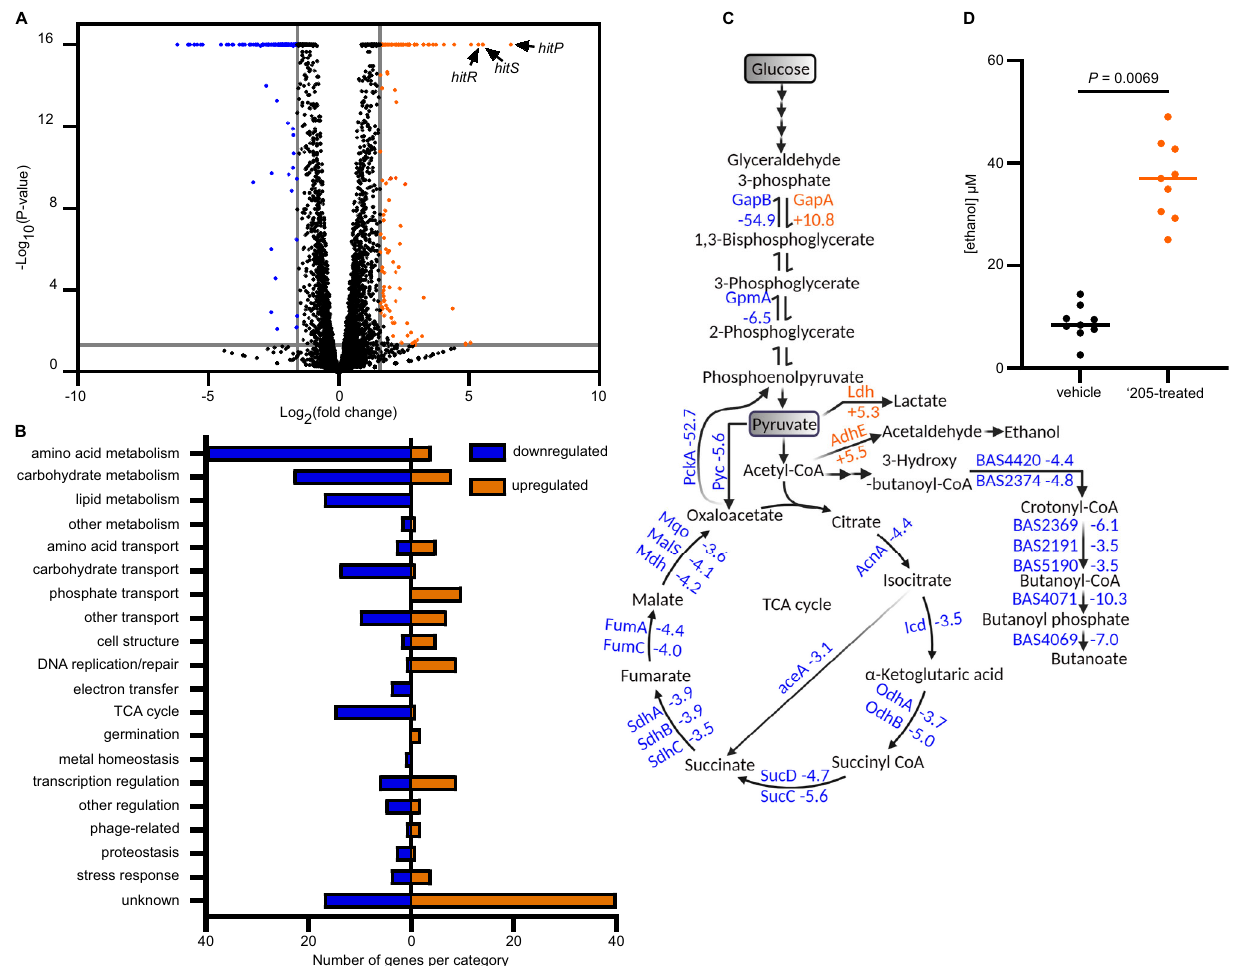
Fig. 6 The HitRS activator ‘ 205 diverts cellular metabolism from aerobic respiration to fermentation. A Volcano plot showing transcriptomic comparison between ‘ 205 (50 µ M) and vehicle treatments of B. anthracis WT. Genes signi fi cantly upregulated or downregulated following ‘ 205 treatment are highlighted in orange or blue, respectively. The fold change cutoff is ≥ 3 and the P value cutoff is <0.05, both of which are indicated by gray lines. B Genes identi fi ed in the RNA-seq analysis with signi fi cantly differential expression grouped into predicted functional categories. C A subset of notable metabolic pathways that showed signi fi cantly different expression following ‘ 205 treatment: glycolysis, gluconeogenesis, and TCA cycle. Products of genes with increased expression are labeled in orange while the ones with decreased expression are labeled in blue. The fold change of each speci fi c gene is indicted: + , upregulation; − , downregulation. D Ethanol concentration was quanti fi ed in the spent media of WT cell cultures in the absence or presence of 50 µ M ‘ 205. ‘ 205 drives glucose metabolism towards pyruvate fermentation, resulting in higher level of ethanol compared to vehicle control. Data shown are three independent experiments with three replicates each time (mean± SEM; n = 9). Signi fi cant differences are determined by two-tailed t